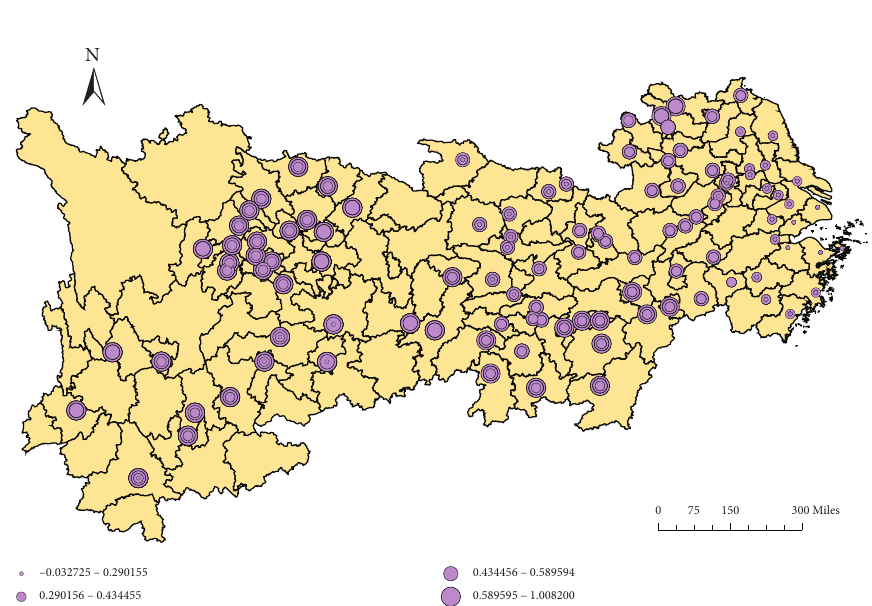
Figure 2: Spatiotemporal distribution of educational development.